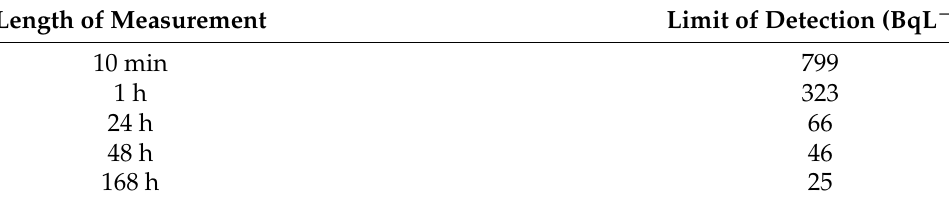
Table 2. The limit of measurement for 90 Sr in the cadmium telluride (CdTe) detector for increasing lengths of